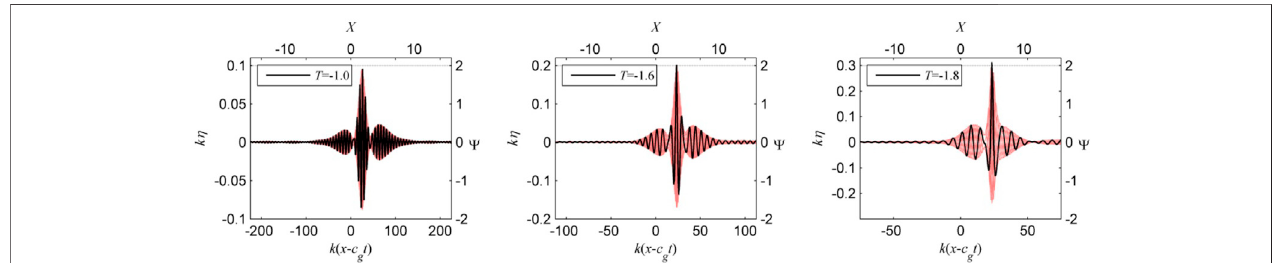
FIGURE 8 | Extreme events with highest amplitude during the evolution presented in Figure 6 .